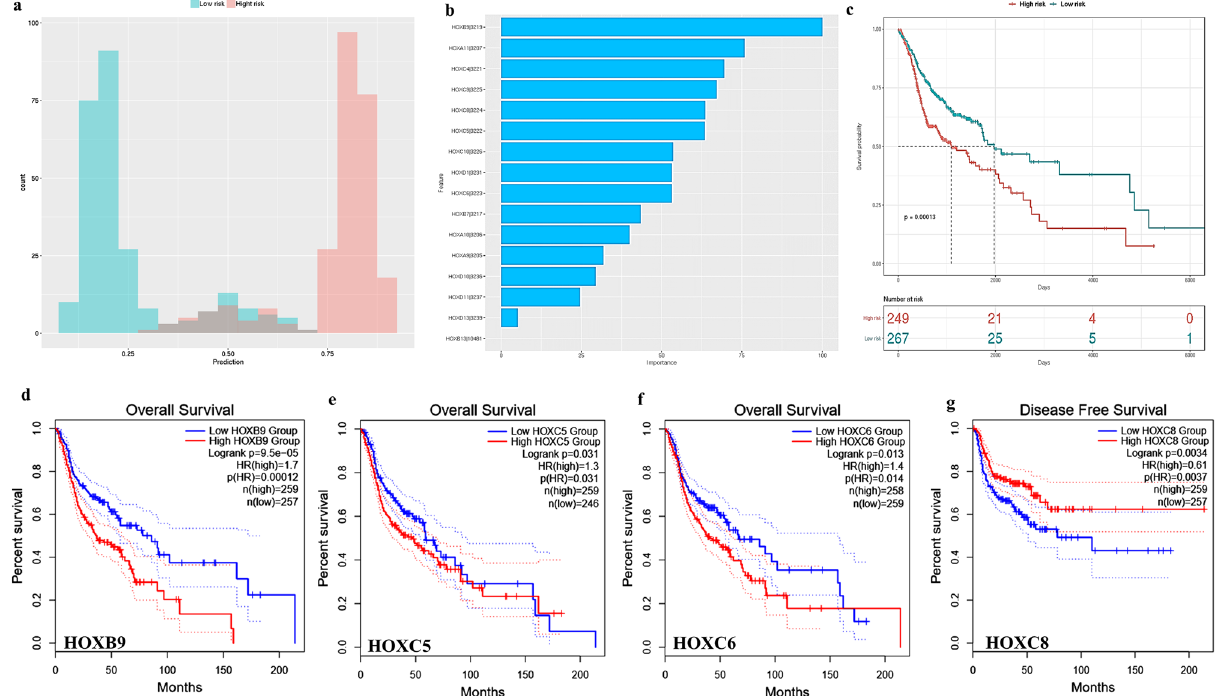
Figure 4. Survival analysis of DEHGs: ( a ) Represents the survival analysis of DEHGs by constructing the prediction model using Random Forest Algorithm: Patients with prediction score larger than 0.5 is considered as high risk, while lower than 0.5 is classified under low risk using log-rank test. ( b ) The contribution of each DEHGs to HNSCC prognosis. ( c ) The Kaplan–Meier survival plot represents the number of patients surviving at each specific time point. ( d-g ) Kaplan–Meier plot of DEHGs associated with overall survival (OS) and disease-free survival (DFS).